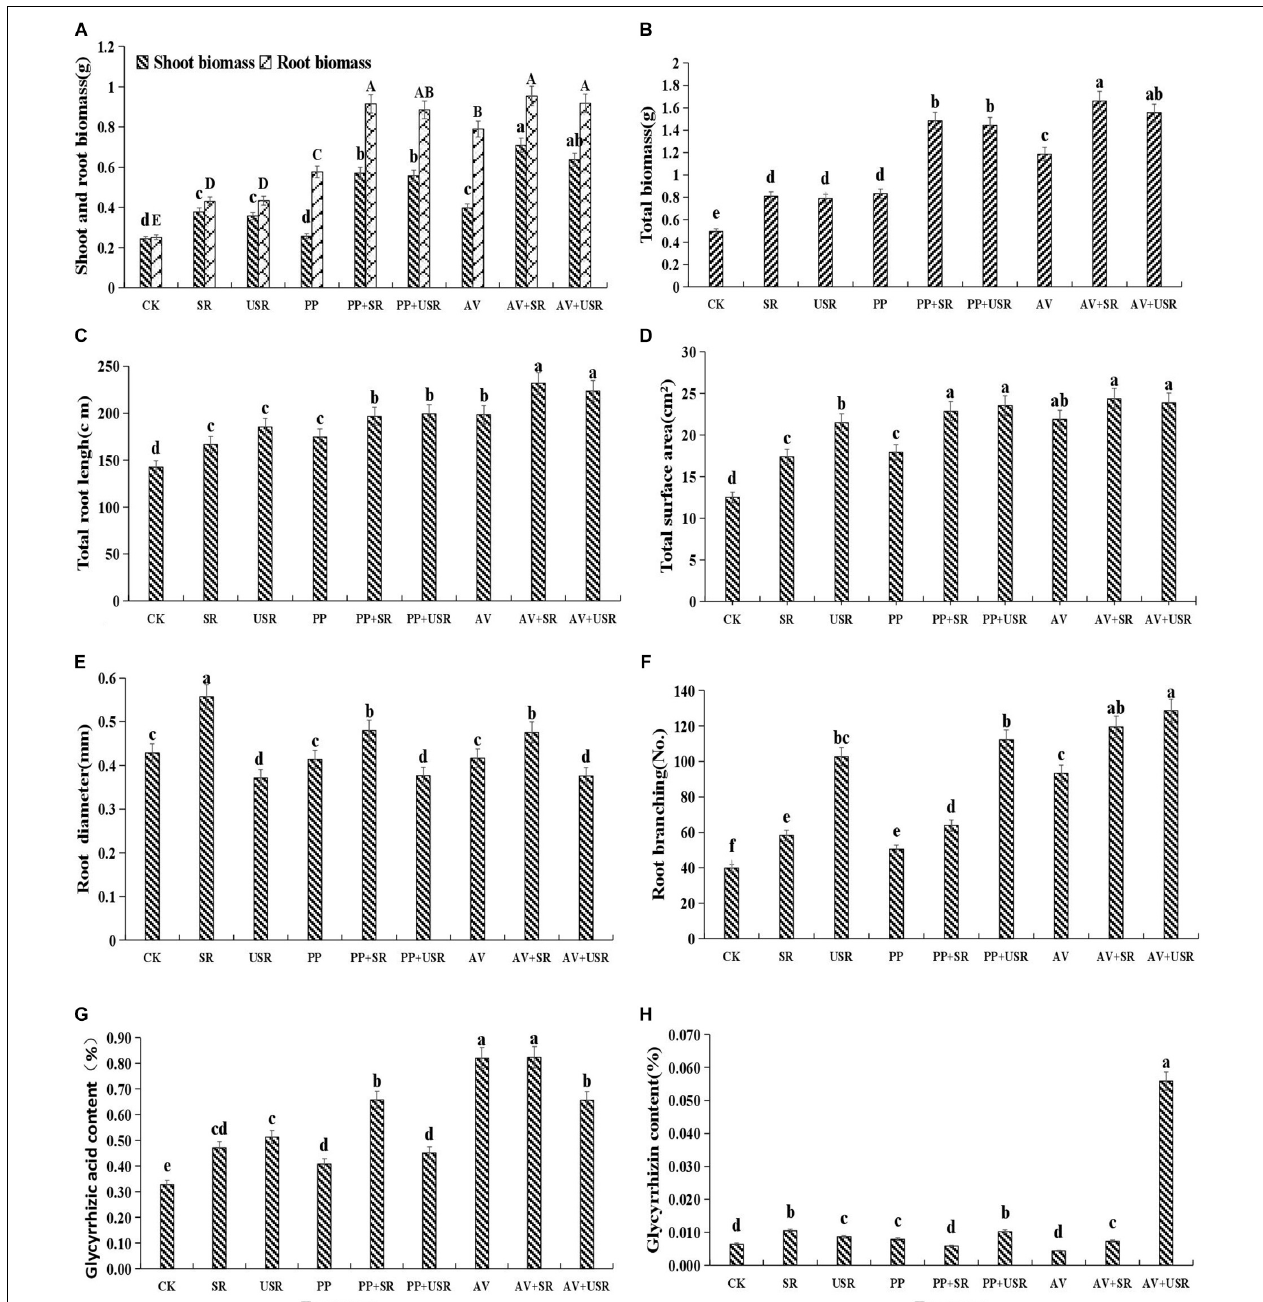
FIGURE 4 | Effects of dark septate endophyte (DSE) inoculation and residues treatment on the growth and active ingredient content of liquorice plants. The error bars represent the standard error (SE). Different letters above the error bars indicate significant difference at P < 0.05 by Duncan’s multiple-range tests. CK indicates non-inoculated plants and no residues. SR, sterilized residue. USR, unsterilized residue. AV, A. vagum . PP, P. putaminum . AV + SR, A. vagum + sterilized residue. AV + USR, A. vagum + unsterilized residue. PP + SR, P. putaminum + sterilized residue. PP + USR, P. putaminum + unsterilized residue. The shoot biomass and root biomass of liquorice plants (A) , total biomass of liquorice plants (B) , total root length of liquorice plants (C) , total root surface area of liquorice plants (D) , root diameter of liquorice plants (E) , root branching of liquorice plants (F) , glycyrrhizic acid content of liquorice plants (G) , glycyrrhizin content of liquorice plants (H) .